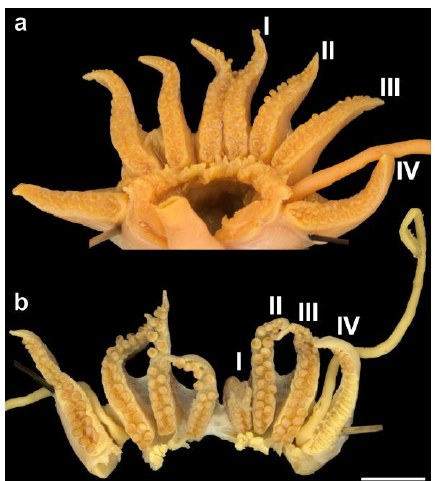
Figure 13. Arms of Sepia typica : ( a ) Female SAIAB 211684, ML 23 mm; ( b ) Male SAIAB 211655, ML 21 mm. Roman numerals indicate the right member of each arm pair I–IV. Scale bar 5 mm. Suckers on all arms globose, consistently biserial. Sucker rings with tiny teeth (difficult to see) that are only on the aboral side of arm suckers (Figure 14a), but round the whole circumference of the chitinous ring on club suckers (Figure 14b). Near the tip on all